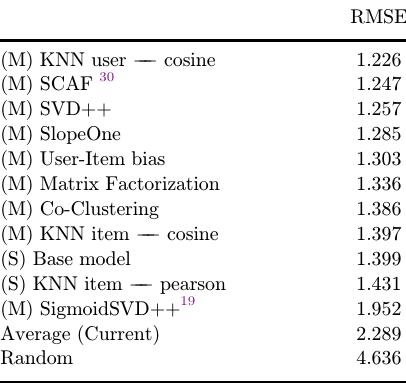
Table 2. Results for the rating prediction task. (M) denotes a MyMediaLite implementation and (S) denotes a Surprise implementation.